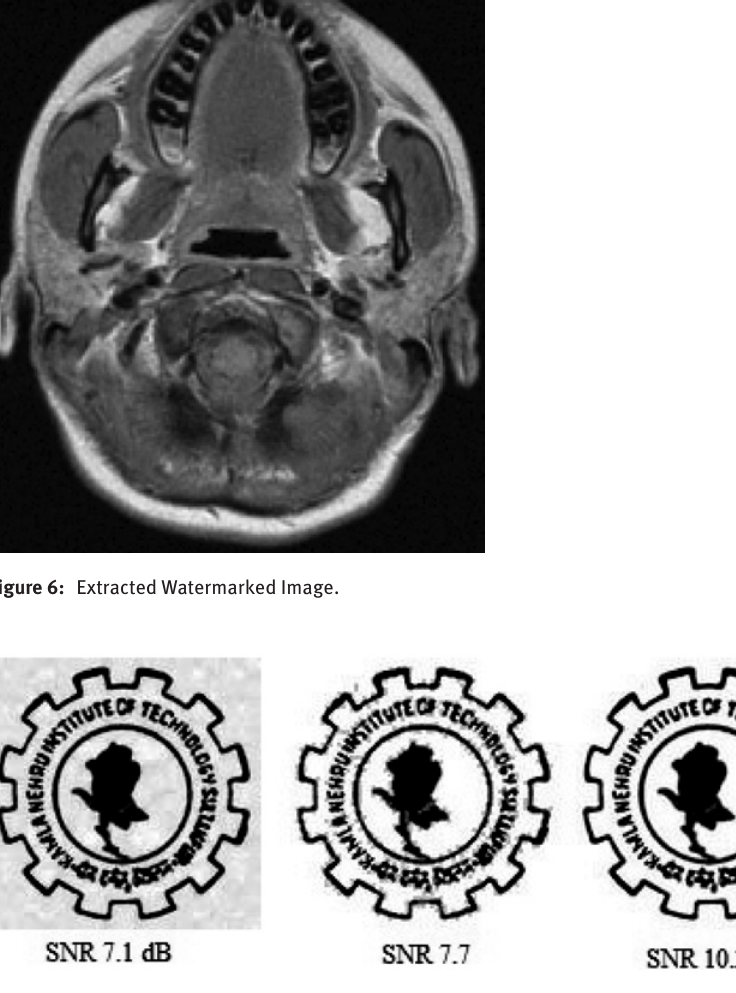
Figure 7: Extracted Watermark at Different SNRs.